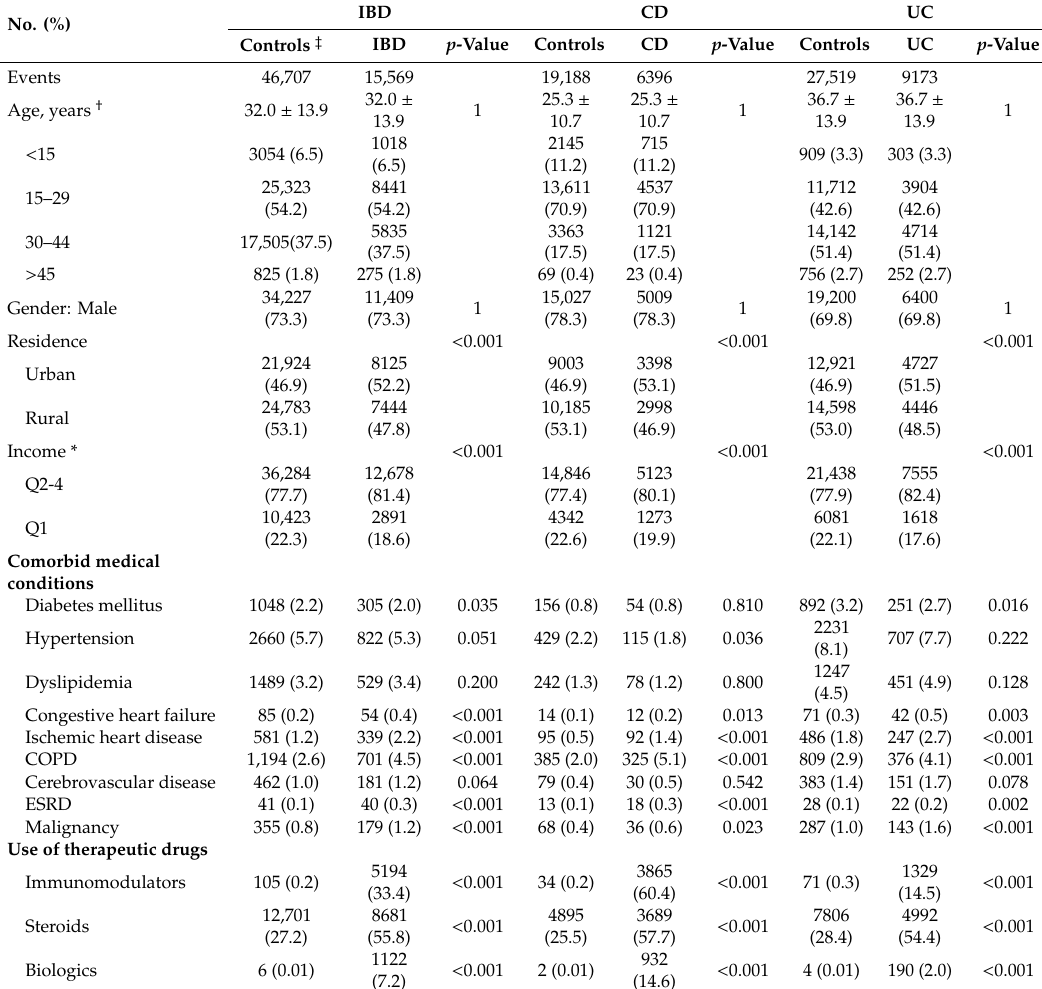
Table 1. Baseline characteristics of the study